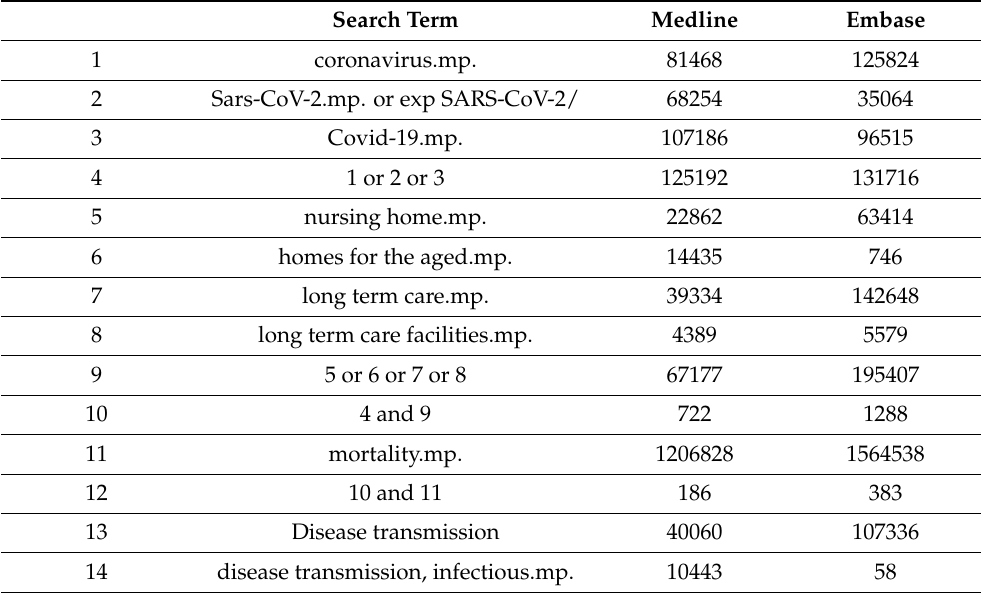
Table 2. Literature searches 9 March 2021 in Medline and